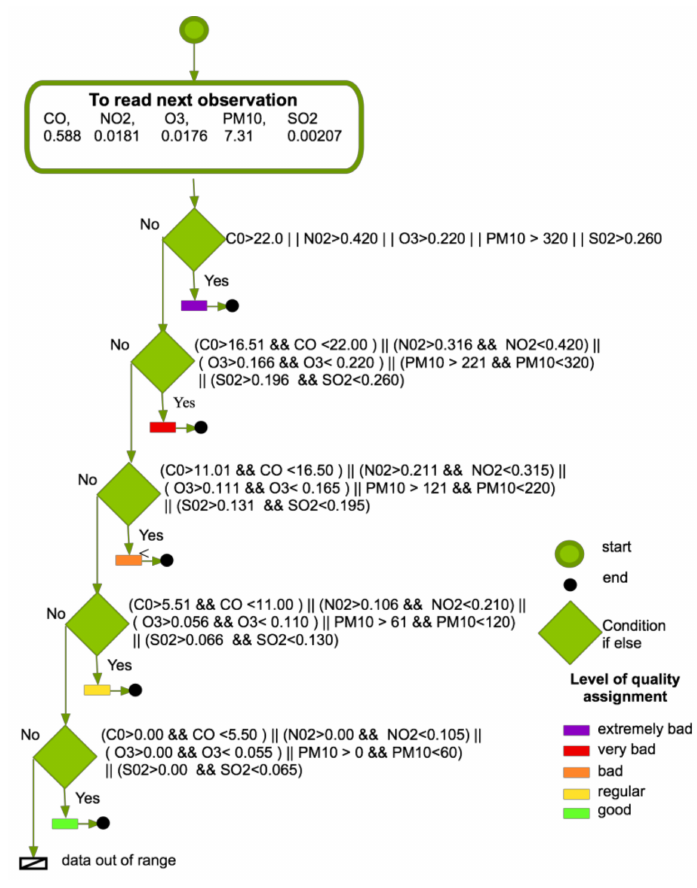
Figure 6. Flowchart for level classification.